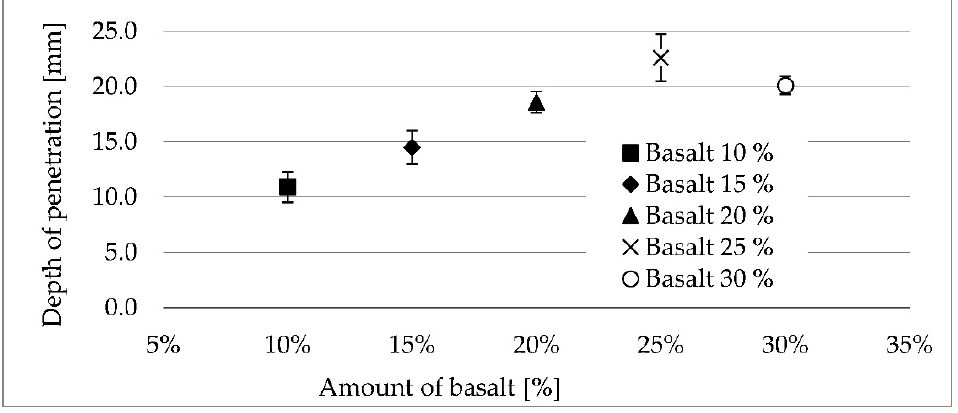
Figure 16. Depth of penetration by percentage substitution.